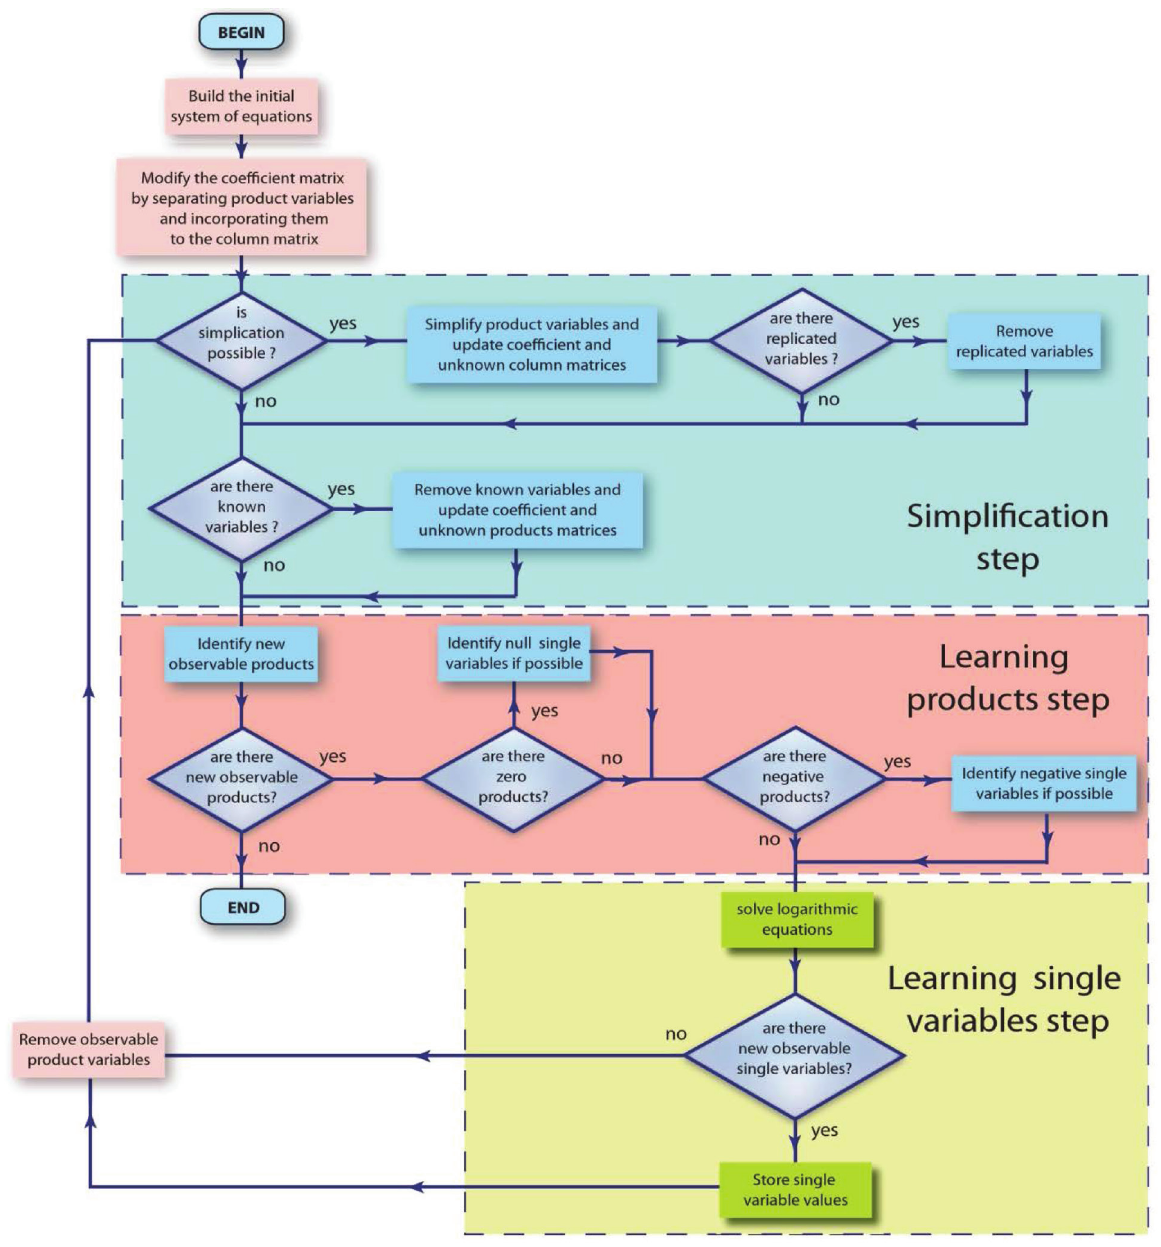
Fig. 3. Flow chart of the proposed method for solving the system of multivariate polyrational equations, showing the simplification step and the learning steps 1 and